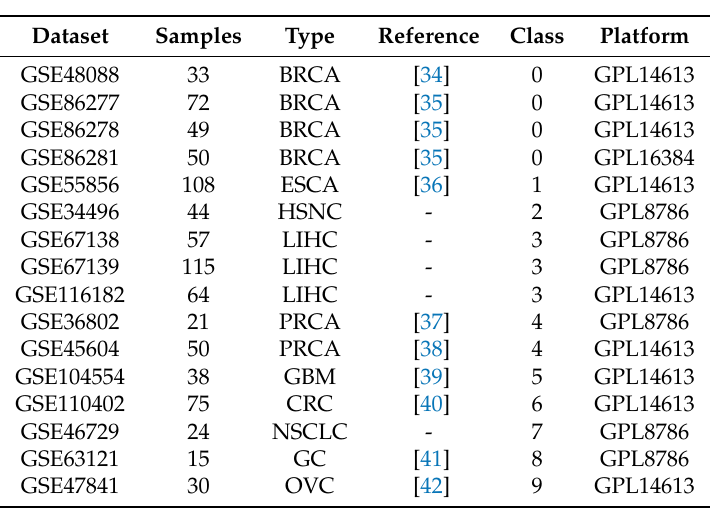
Table 1. Gene expression omnibus (GEO) repository datasets of miRNA cancer studies used in the project for platforms GPL8786, GPL14613 and GPL16384. BRCA: breast cancer; ESCA: esophageal cancer; HSNC: head and neck squamous cell cancer; LIHC: liver hepatocellular cancer; PRCA: prostate cancer; GBM: gliobastoma; CRC: colorectal cancer; NSCLC: non-small-cell lung cancer; GC: gastric cancer; OVC: ovarian